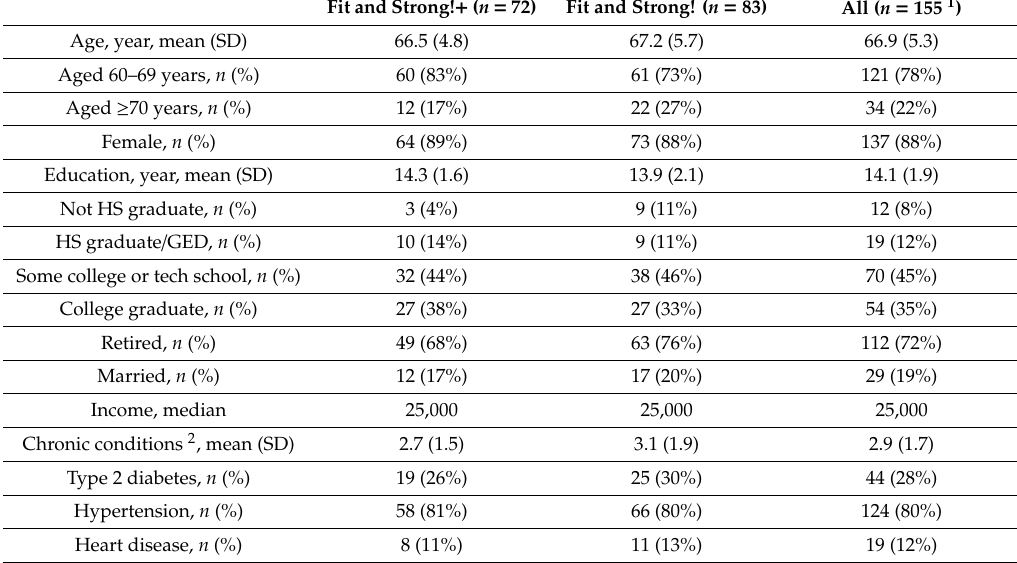
Table 1. Demographic and health characteristics of